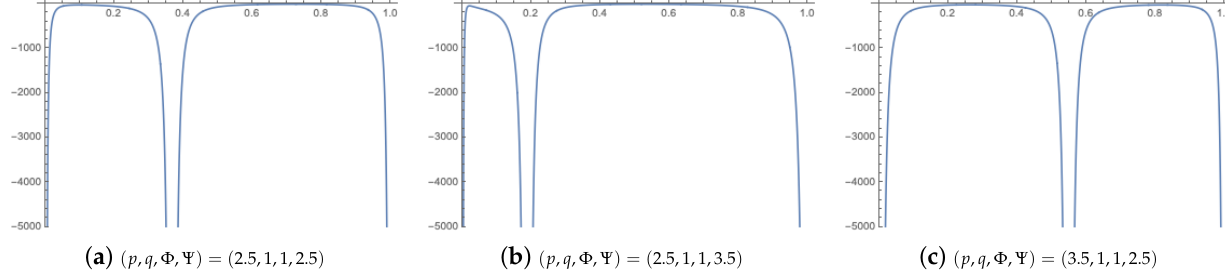
Figure 8. Schwarzian derivatives of r G p ,1,1, Ψ ( x ) = rx p − 1 ( − ln x ) Ψ − 1